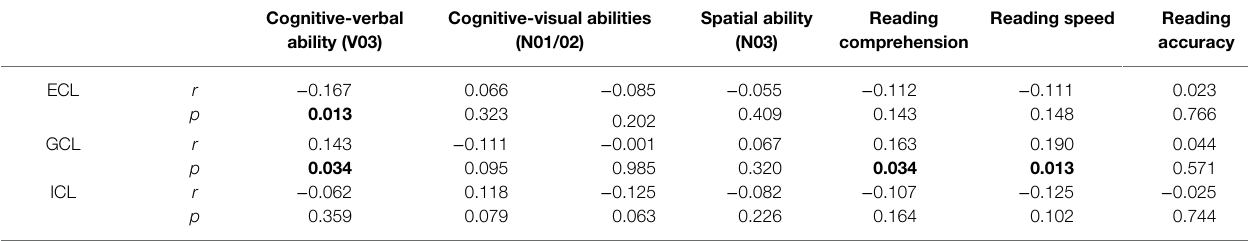
TABLE 5 | Pearson correlation between causal and assessment factors for the total sample.